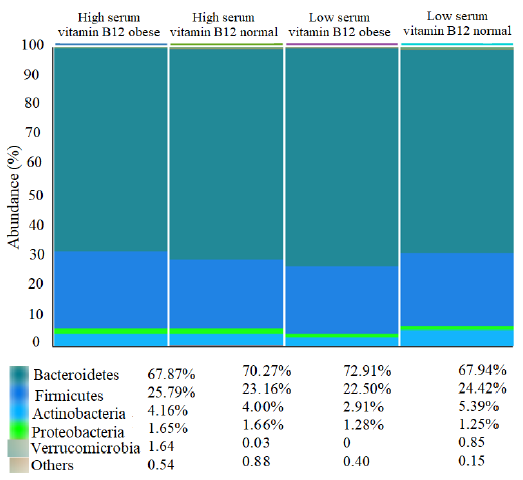
Figure 2. Classification of gut microbiota at phylum-level according to categories of serum vitamin B12 status relative to BMI. The Shannon–Wiener index showed significant differences in α -diversity between participants with high compared to low serum vitamin B12 levels in the obesity and nor- mal-weight groups. Participants with low serum vitamin B12 levels in the obesity group had lower α -diversity than the normal-weight group (median: 4.9 vs. 5.2; p = 0.04, Figure 3). Figure 3. Comparison of bacterial α -diversity (Shannon–Wiener index) between the microbiota of normal-weight and obese participants based on BMI and serum vitamin B12 status (<404.0 pg/mL). * p < 0.05. The principal coordinate analysis (PCoA) plots based on Bray–Curtis showed a sig- nificant difference in β -diversity shown by PC1, PC2 and PC3 accounting for 9.99%, 14.68% and 6.69% (Bray–Curtis index, p = 0.01). Result revealed a significant difference in β -diversity between high serum vitamin B12 in the normal-weight group compared to low serum vitamin B12 in the obese group. 4. Discussion In this study, we explored the association between vitamin B12 status and gut micro- biota among young Saudi females in association to body weight. We found a significant